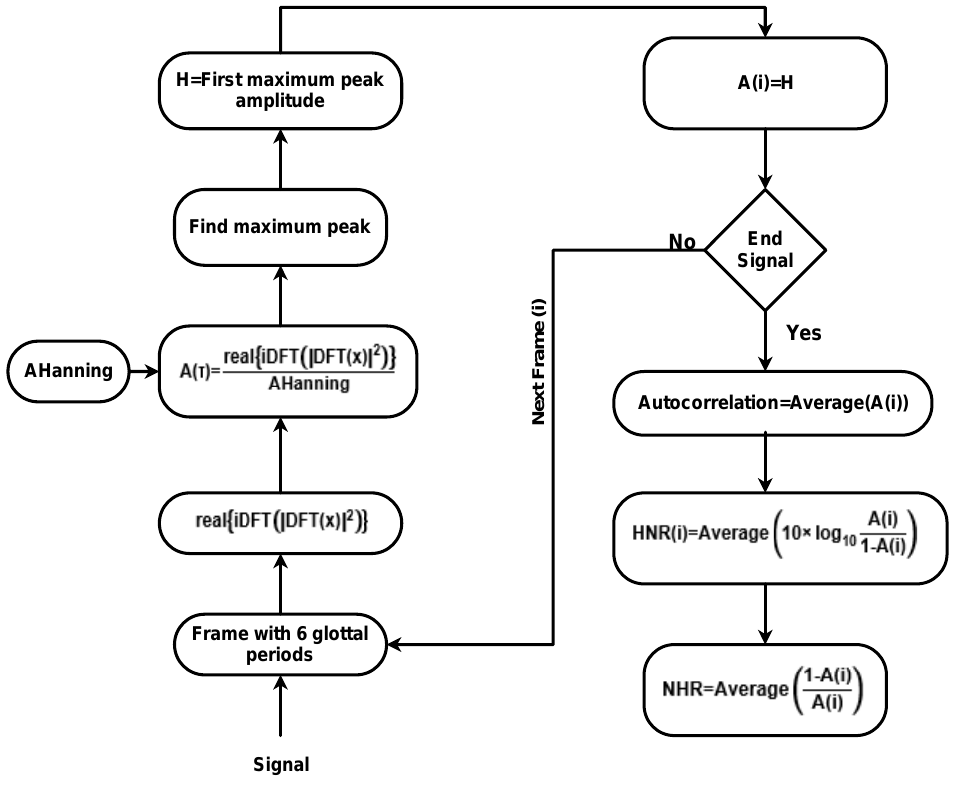
Figure 3. Flowchart of the algorithm to determine Autocorrelation, HNR, and NHR.